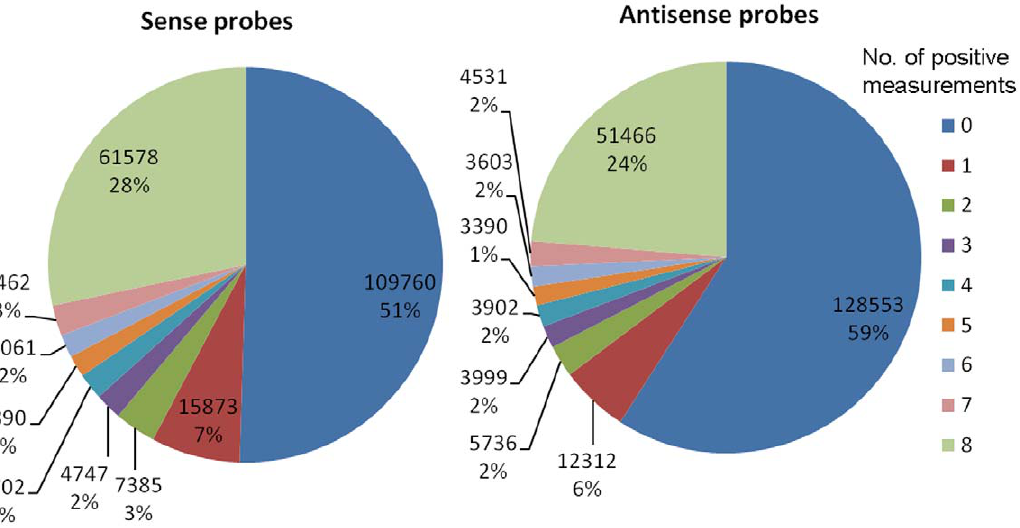
Figure 2. Hybridization results of 60-mer probes. Hybridization results of eArray-designed sense and antisense 60-mer probes showing the number and percentage of probes with 0 to 8 positive measurements. The total number of sense and antisense probes was 217,458 (215,270 unique + 2,188 redundant) and 217,492 (213,756 + 3,736), respectively. Each probe was measured 8 times, i.e., on four arrays (2 array/design) and two PMT gain settings (400 and 500). Results of additional redundant probes included in test array designs TA-1 and TA-2 are not shown because they were measured 4 times if disregarding their repeats.